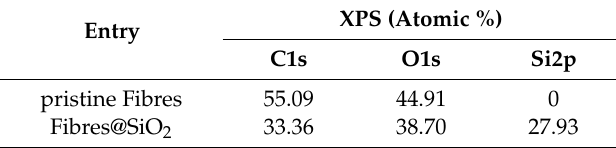
Table 1. XPS elements contents of pristine Fibers and Fibers@SiO 2 composites.